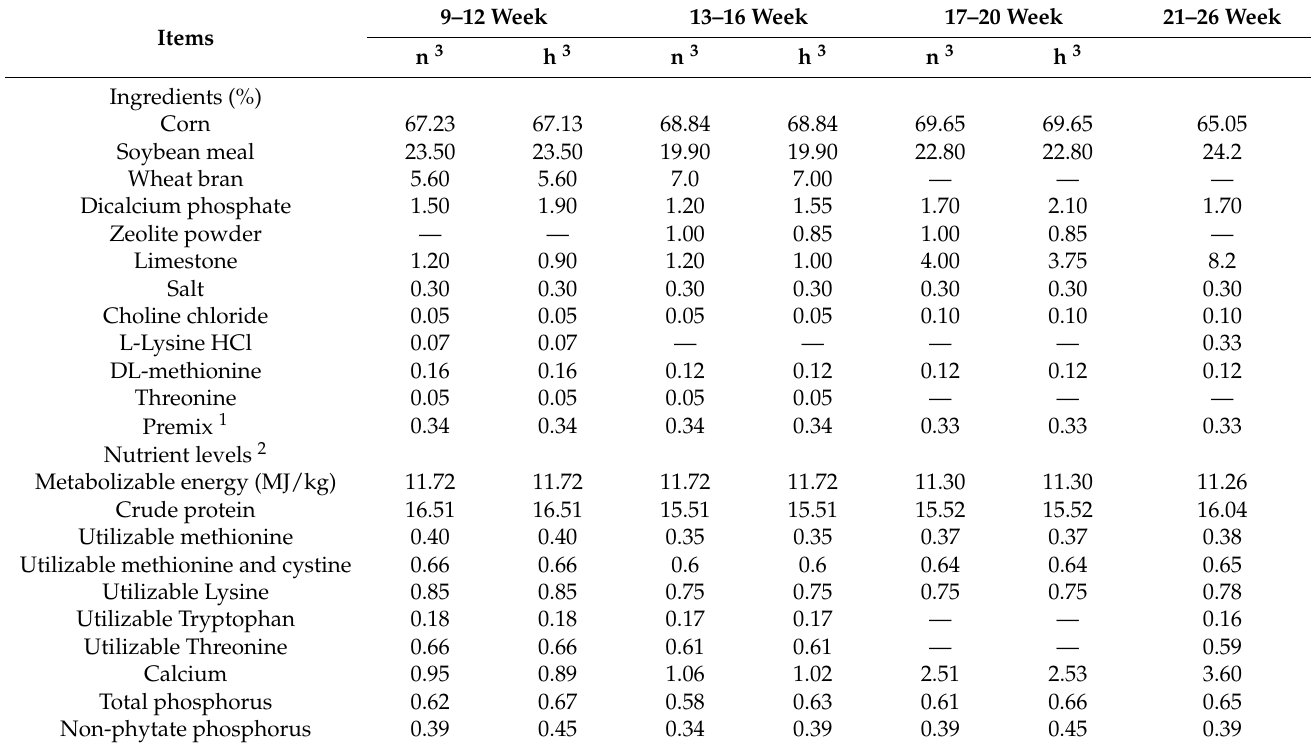
Table 2. Composition and nutrient levels of 9–26 weeks diets (%, air-drying